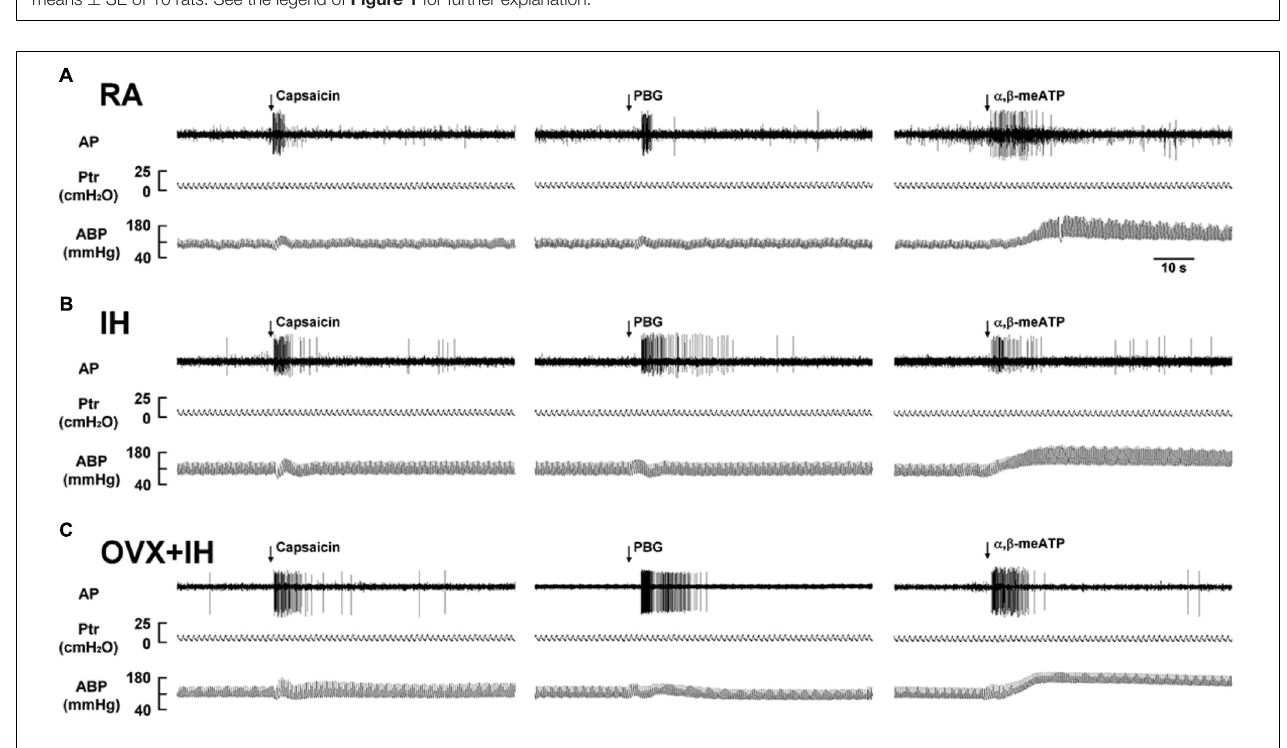
FIGURE 3 | Responses of lung vagal C fibers to intravenous injection of three stimulants in three female rats exposed to RA or IH. (A) Responses of an intact rat exposed to RA; (B) responses of an intact rat exposed to IH; (C) responses of an OVX rat exposed to IH (OVX + IH). Afferent responses to capsaicin, PBG, and α , β -meATP were measured. These stimulants were injected into the jugular vein as a bolus (0.1 ml volume), as indicated by the arrows. Approximately 15 min elapsed between any two injections. AP, action potential; Ptr, tracheal pressure; ABP, arterial blood pressure. See the legend of Figure 1 for further